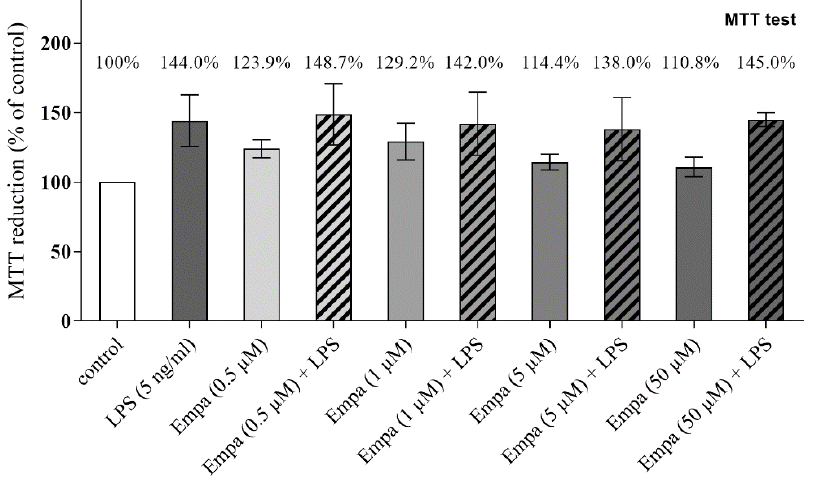
Figure 1. The MTT test was performed to determine the cell viability of primary microglia after treatment with empagliflozin (Empa) at increasing concentration (0.5, 1, 5, 50 µM) alone or in combination with LPS (5 ng/mL). Cell viability remained unchanged in the different groups after stimulation in comparison to control (one-way ANOVA, followed by Dunnett’s test; F-value = 1.286; n = 4).